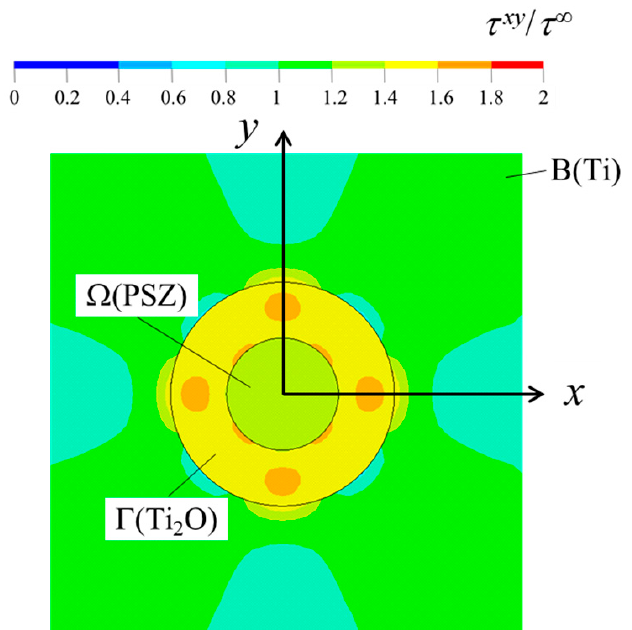
Figure A2. Distribution of shear stress τ xy in the vicinity of a double inclusion.